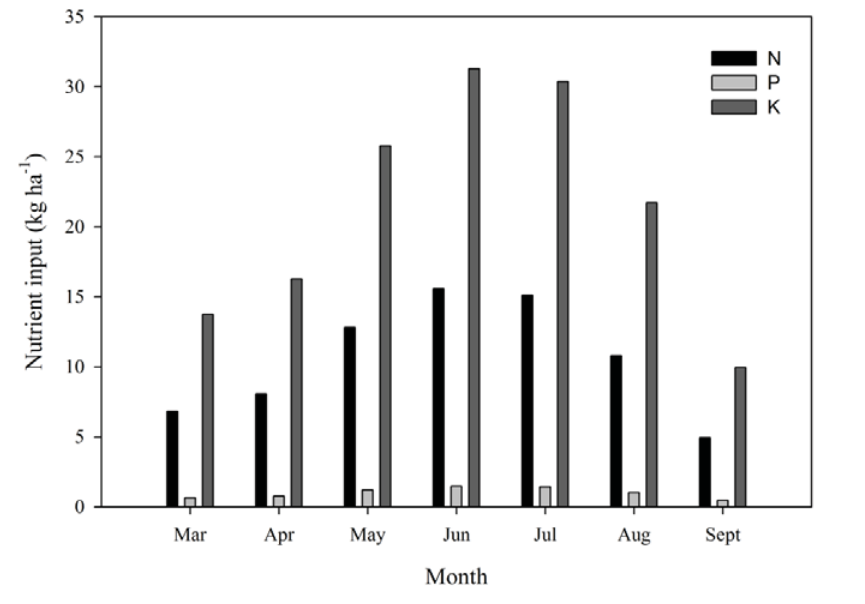
Figure 3. N-P-K input from effluent irrigation ( IR = 779 mm, LF = 0) during one growing period of jatropha in Tan-Tan,